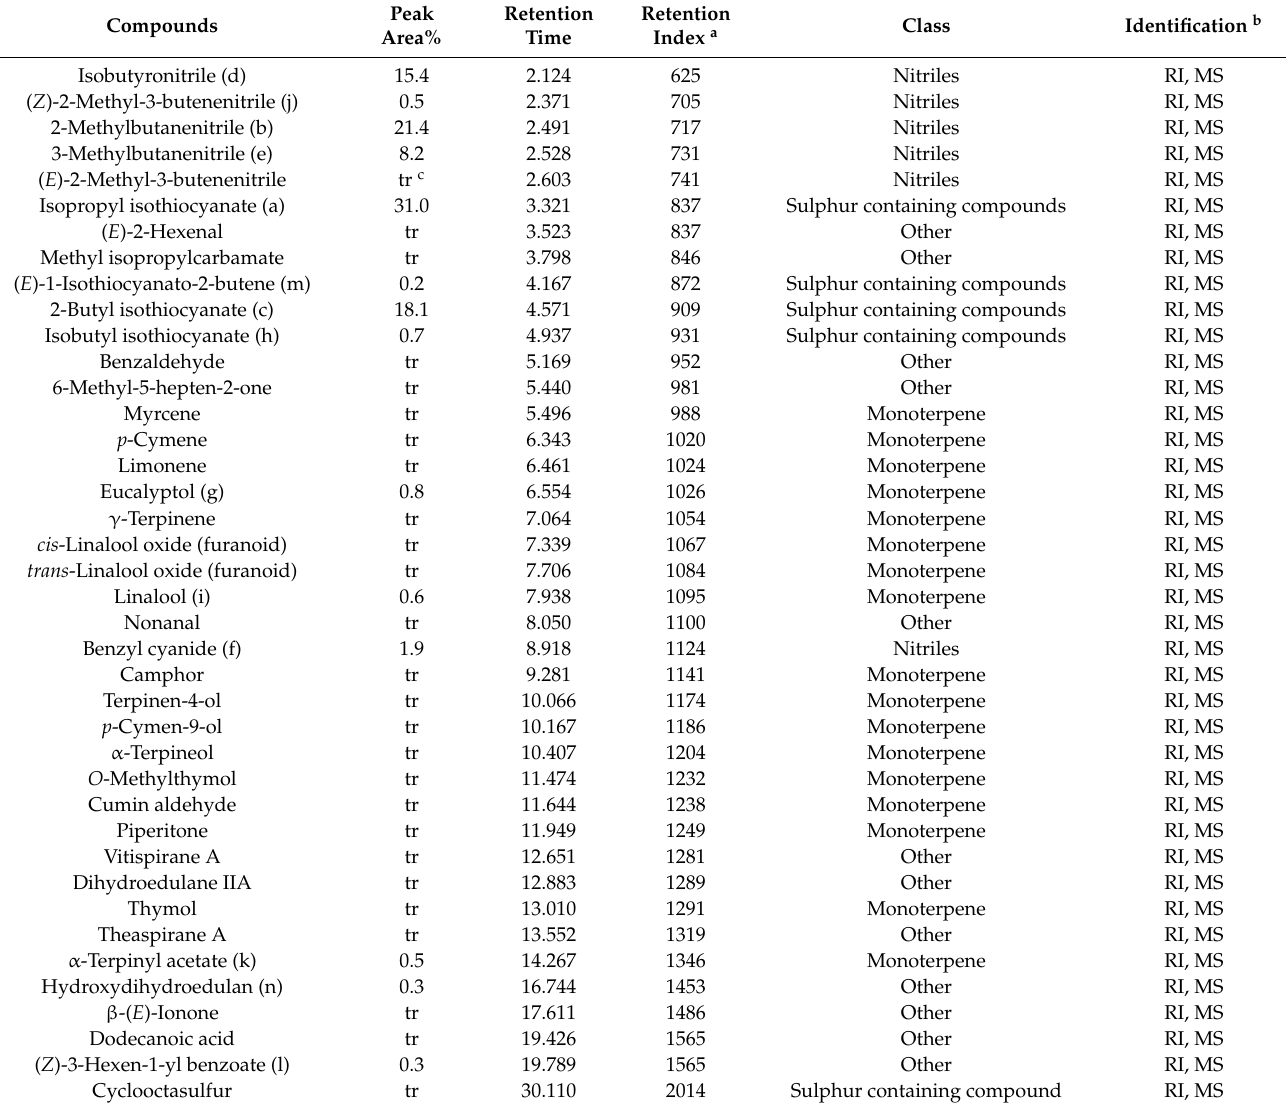
Table 1. Composition of the leaf essential oil of Capparis cartilaginea from Saudi